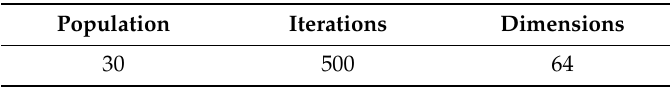
Table 8. Parameters used in the WDO, DSO, and FA methods.